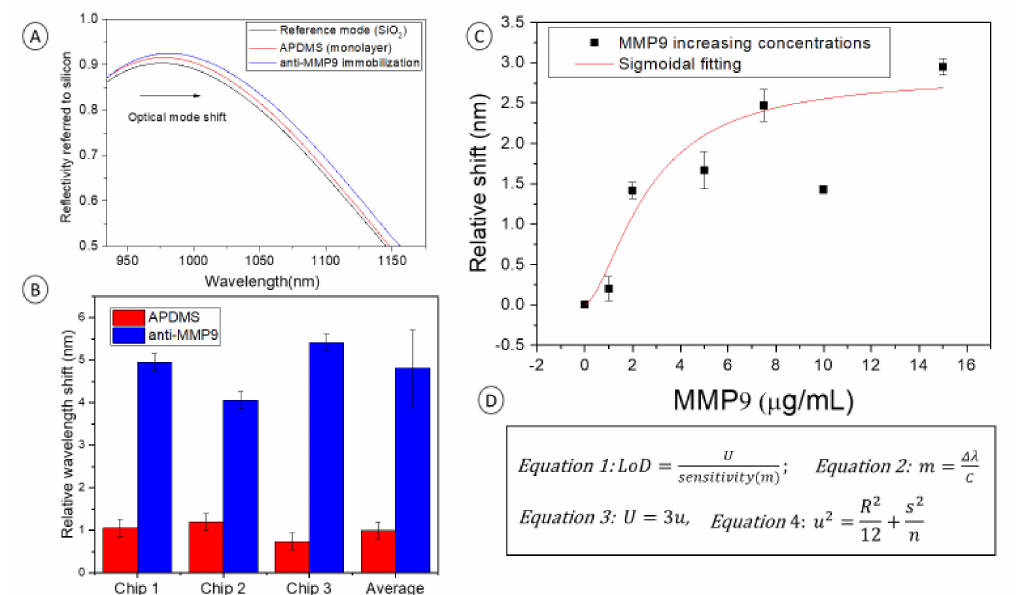
Figure 5. ( A ) Optical mode shift along the wavelength on the different processes: SiO 2 surface (black), APDMS mono- layer (red), and anti-MMP9 immobilization (blue). ( B ) Relative wavelength shift after APDMS surface modification (red columns) and after anti-MMP9 immobilization (blue columns). ( C ) Recognition curve of increasing concentration of MMP9. ( D ) Equations used for the calculations of figure of merit sensitivity and